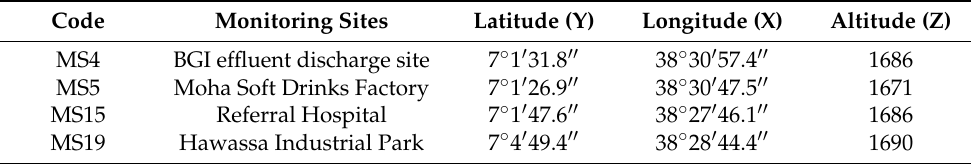
Table 2. Monitoring stations from point sources in Lake Hawassa Watershed.